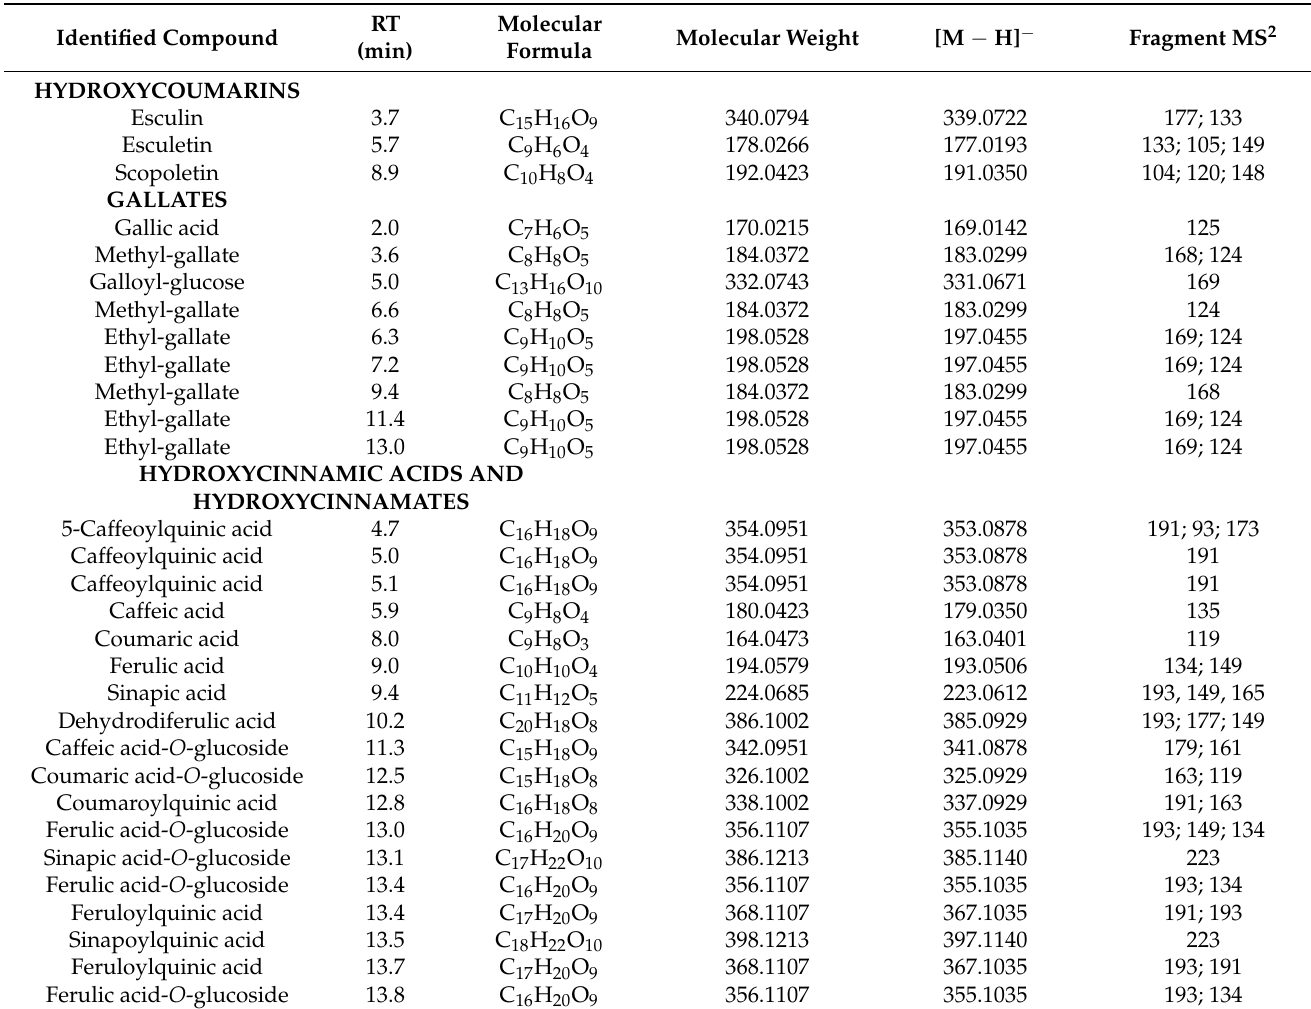
Table 2. LC-QToF identification of phenolic compounds of Brunfelsia grandiflora